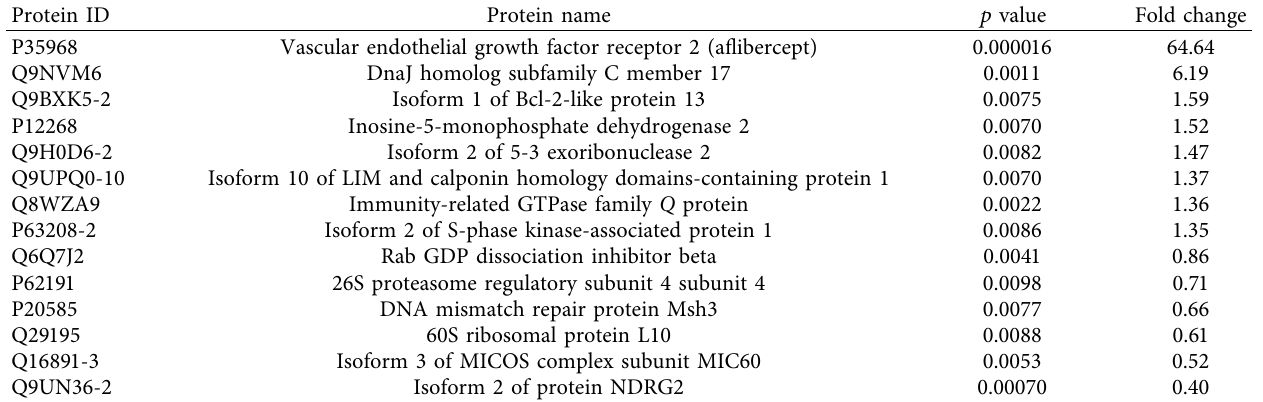
Figure 1: Experimental branch retinal vein occlusion (BRVO). (a) Fundus image of BRVO taken approximately 10 minutes after BRVO was induced in the inferior retina. Black arrow: site of occlusion. White arrow: dilated vein upstream of occlusion. (b) Validation of BRVO by fluorescein angiography five days after BRVO. No passage of fluorescein through the occluded vein is observed. Shunting to adjacent veins is observed. White arrow: site of occlusion. Table 1: Proteins which were regulated following aflibercept intervention in experimental